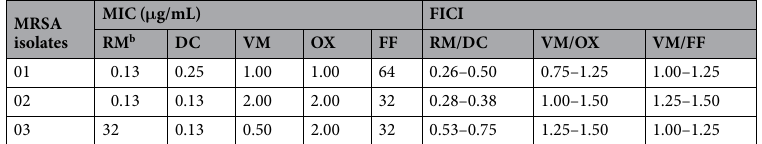
Table 1. Minimal inhibitory concentrations (MICs) of five agents and fractional inhibitory concentration Indices (FICIs) of three combinations against three clinical MRSA isolates a . a The data of FICI were published as an abstract of oral presentation at ISAAR&ICIC 2017 42 . b RM: roxithromycin, DC: doxycycline, VM: vancomycin, FF: fosfomycin, OX: ofloxacin.